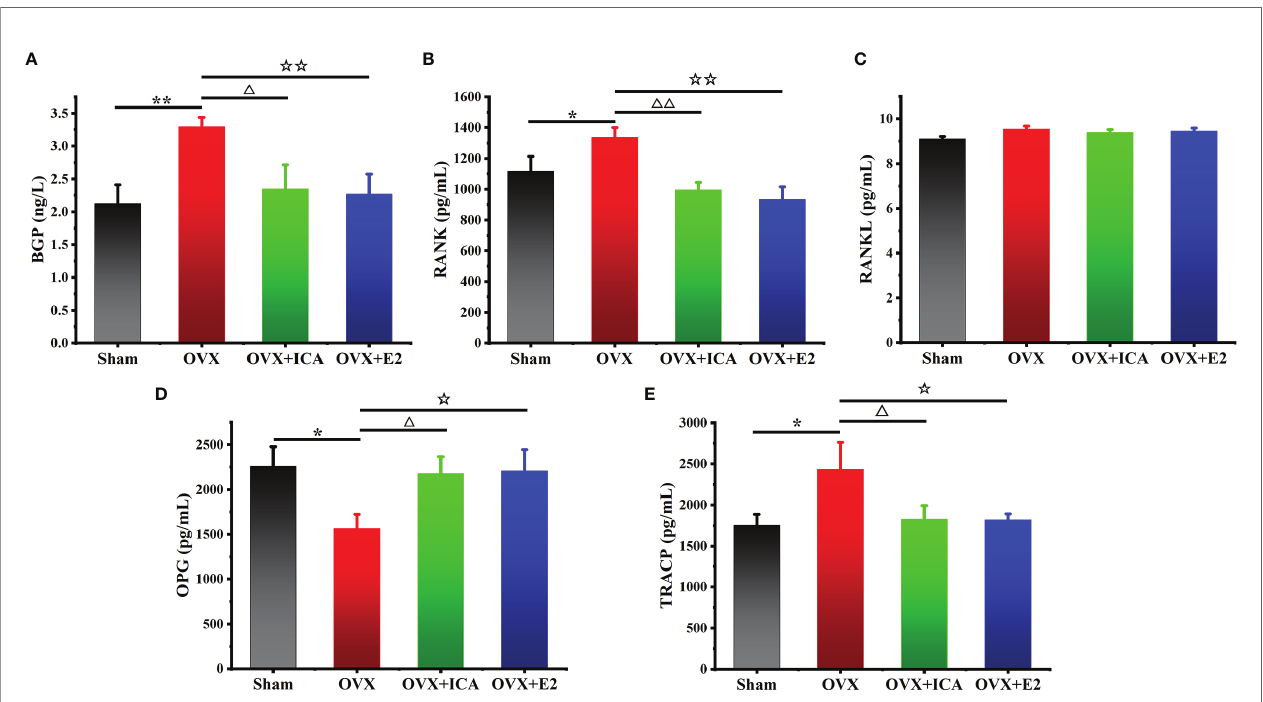
FIGURE 3 | Therapeutic effects of different treatments on serum concentrations of BGP (A) , OPG (B) , RANK (C) , RANKL (D) and TRACP (E) in PMOP model (n = 6). * , △ , ☆ p < 0.05, ** , △△ , ☆☆ p <